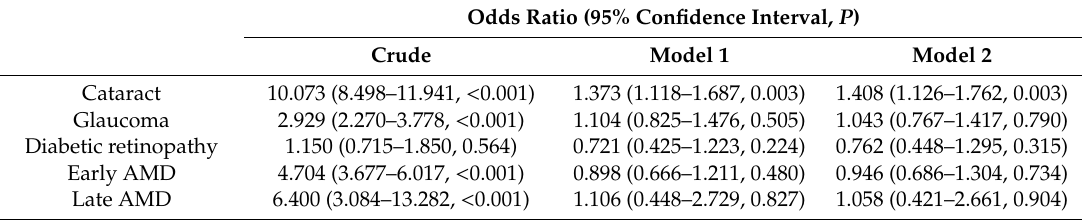
Abbreviations: OR, odds ratio; CI, confidence interval. ORs (95% CIs, P -value). Model 1 adjusted by age and sex. Model 2 adjusted by age, sex, alcohol, smoking, systolic BP, diastolic BP, waist circumference, BMI, fasting blood sugar, total cholesterol, HDL, and triglyceride. Logistic regression